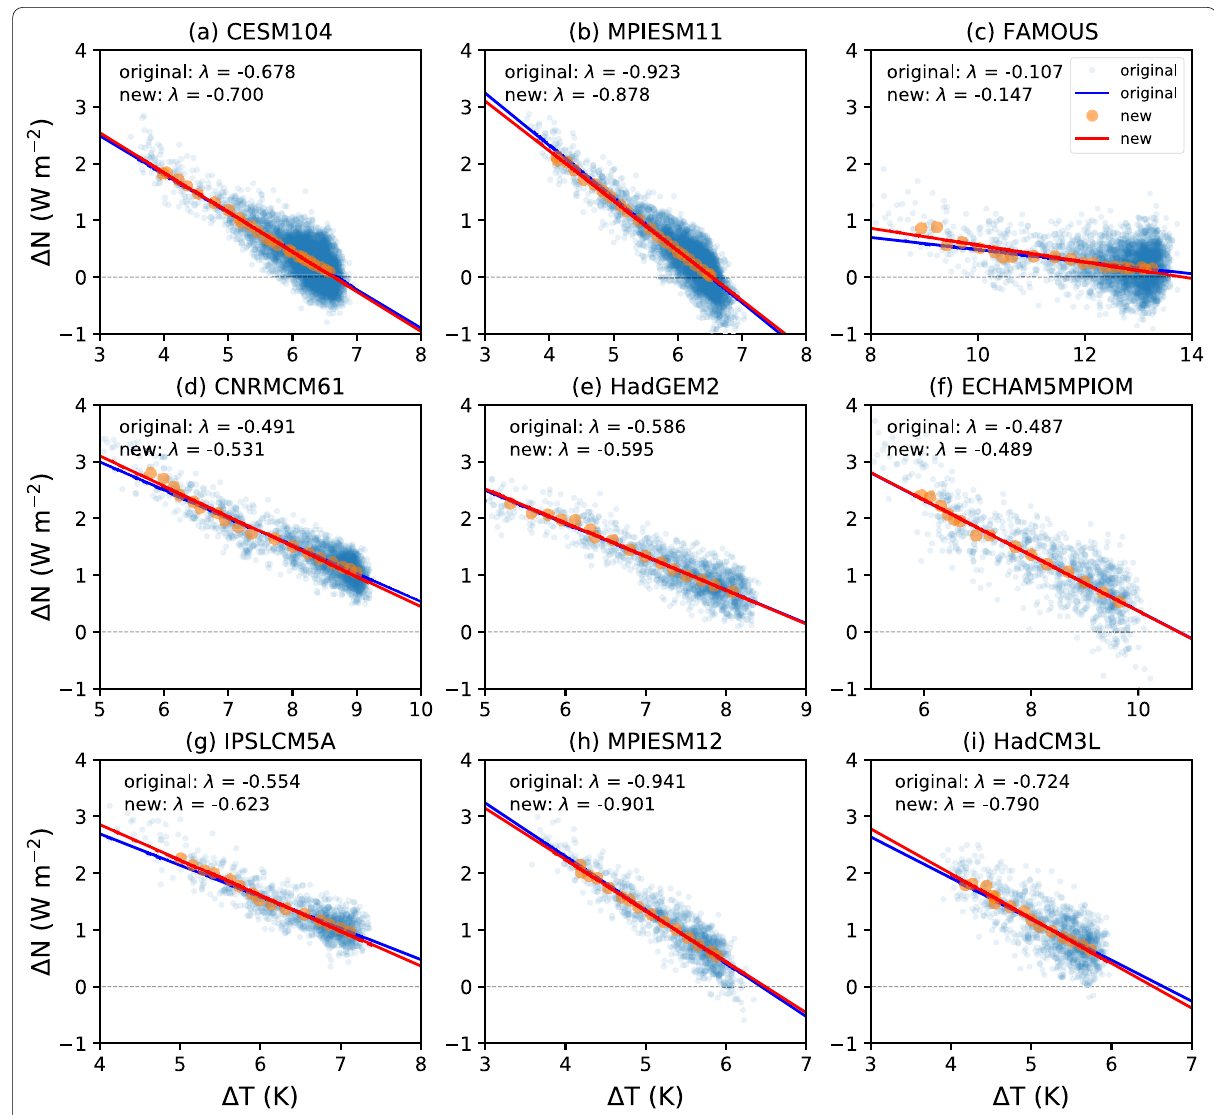
Fig. 2 Scatterplots of the anomalies (relative to piControl) of the global-mean and annual-mean surface temperature (cid:31) T ( x -axis) and TOA net radiative flux (cid:31) N ( y -axis) in the abrupt4xCO2 experiments of LongRunMIP models. The original scatters start from the 50th year (blue dots, blue line linear fit) and the new series starts from the 21st point (average from the original year 50 to 62) (orange dots, red line = of the linear fit on the original and new series are denoted as λ in the top-left